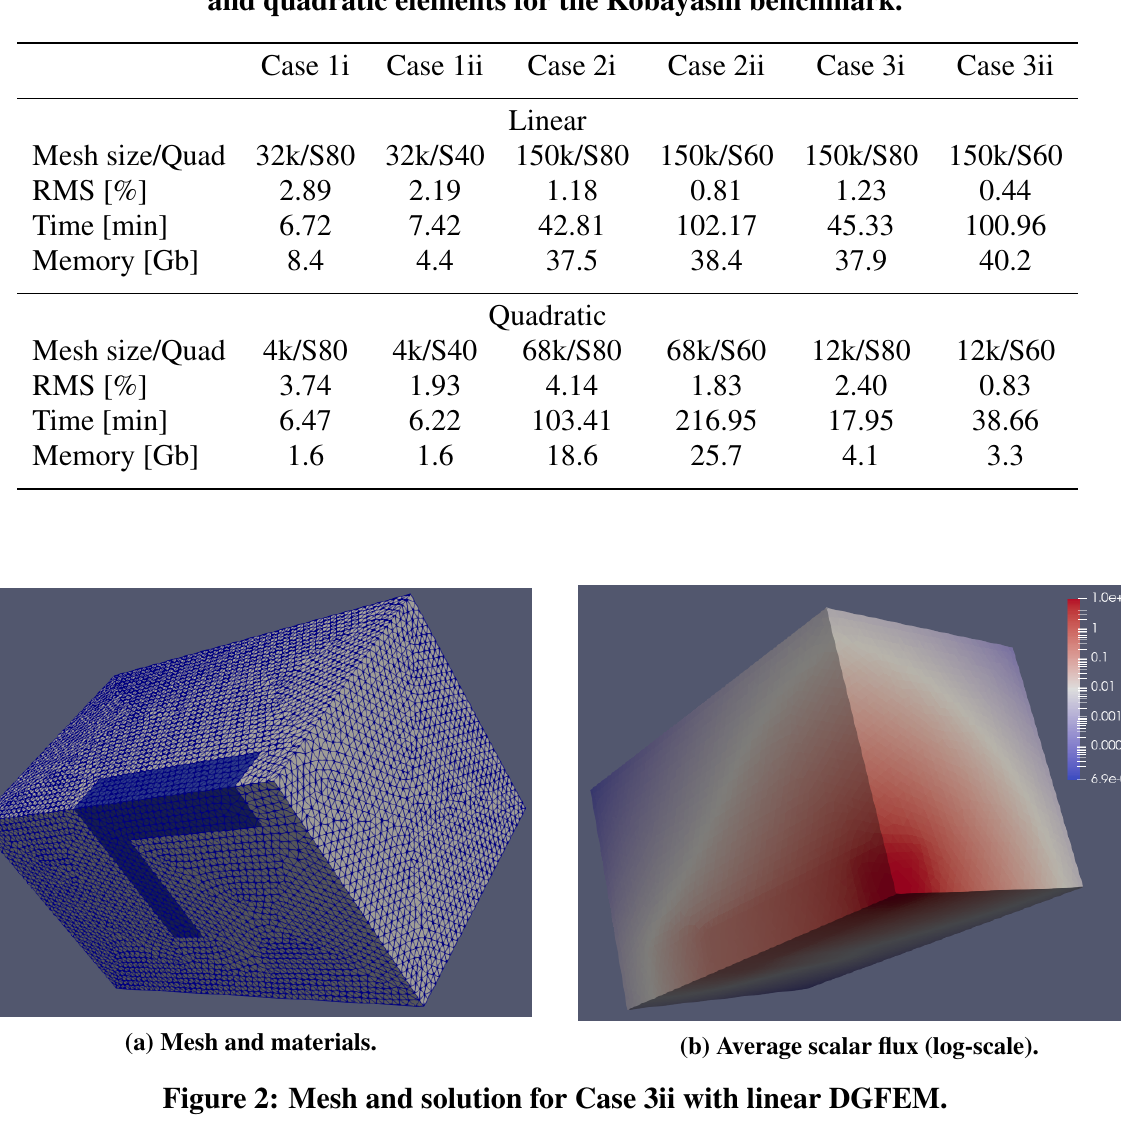
Table 1: Summary of mesh size, quadrature, computing time and memory usage for linear and quadratic elements for the Kobayashi benchmark.